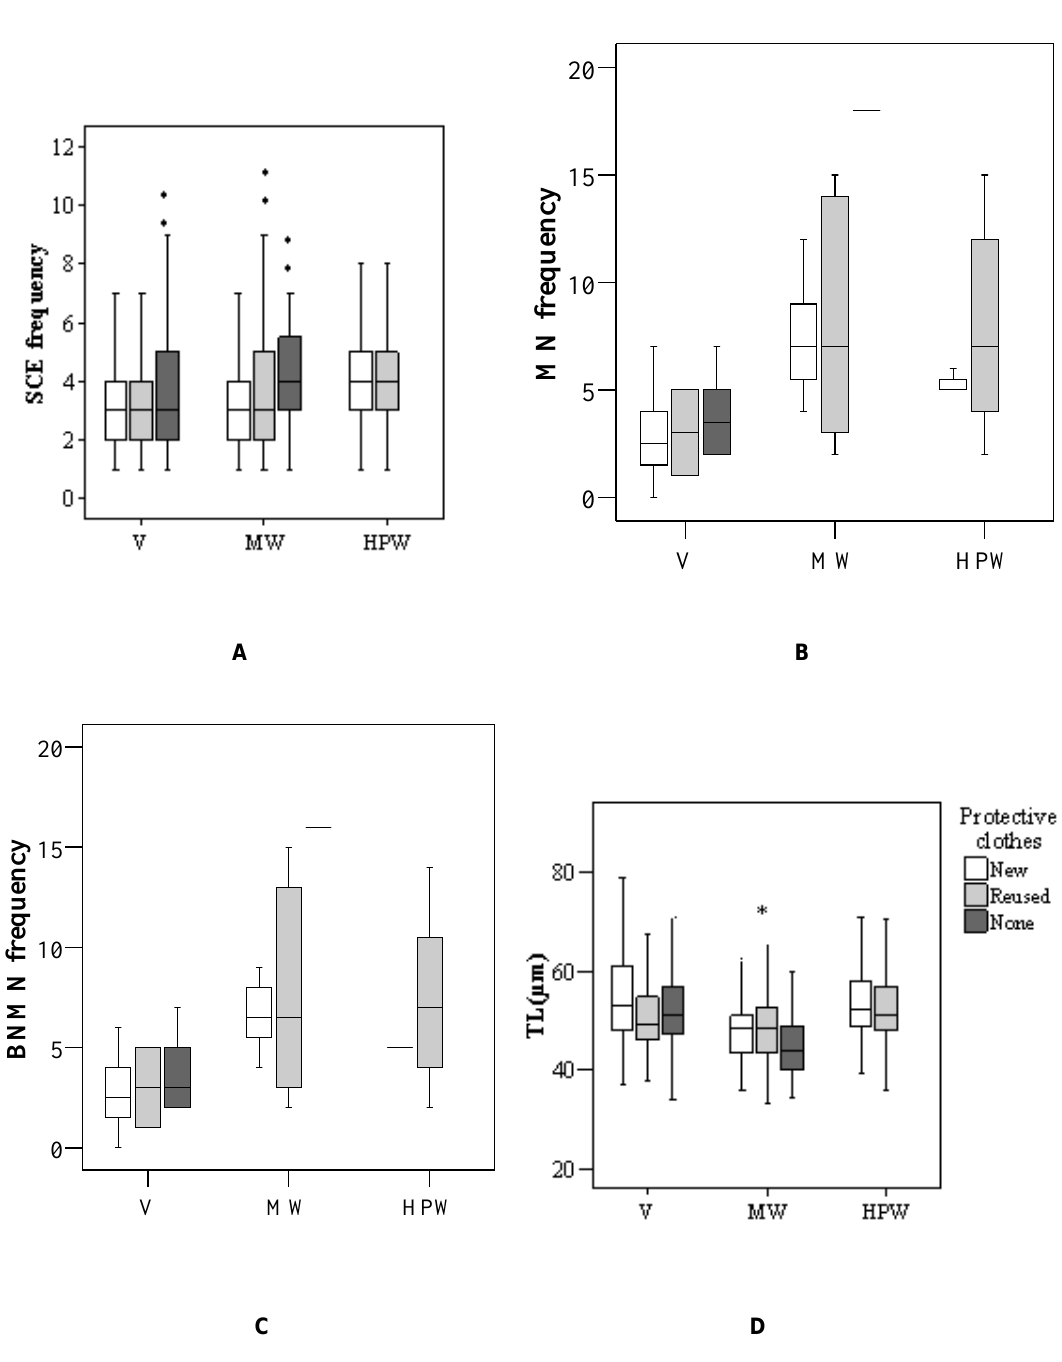
FIGURE 3. Boxplots showing SCE frequencies (a), MN frequencies (b), BNMN frequencies (c), and TL (d) in the exposed groups according to the use of protective clothes. * p < 0.05, ** p < 0.01, significant difference with regard to the use of new